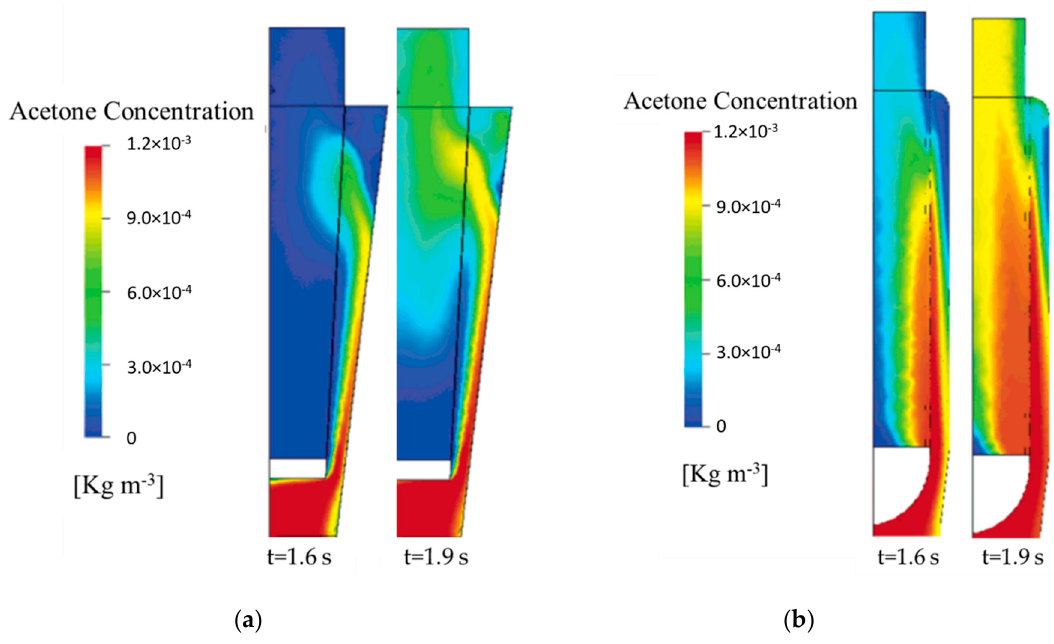
Figure 16. Snapshots of acetone concentrations plotted on the YZ-symmetry plane at t = 1.6 and 1.9 s for ( a ) PCAR-1 and ( b ) PCAR-2 [9].